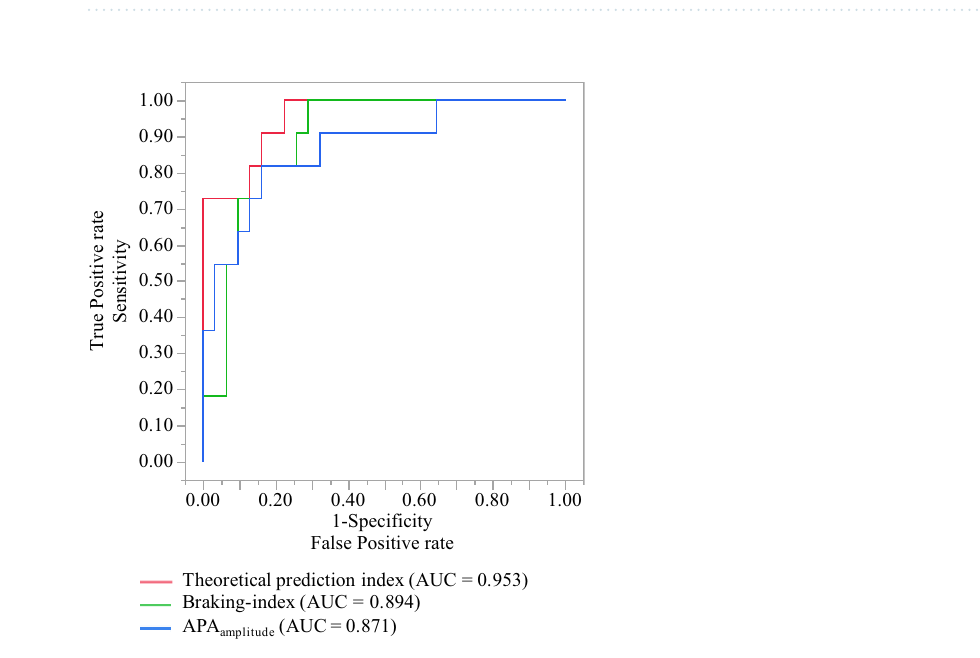
Figure 1. Discriminatory performances (AUCs obtained from ROC curves) of the biomechanical classifiers of gait initiation and the theoretical discrimination index of postural instability (PI th ) classifier, and the differences in discriminatory performance of